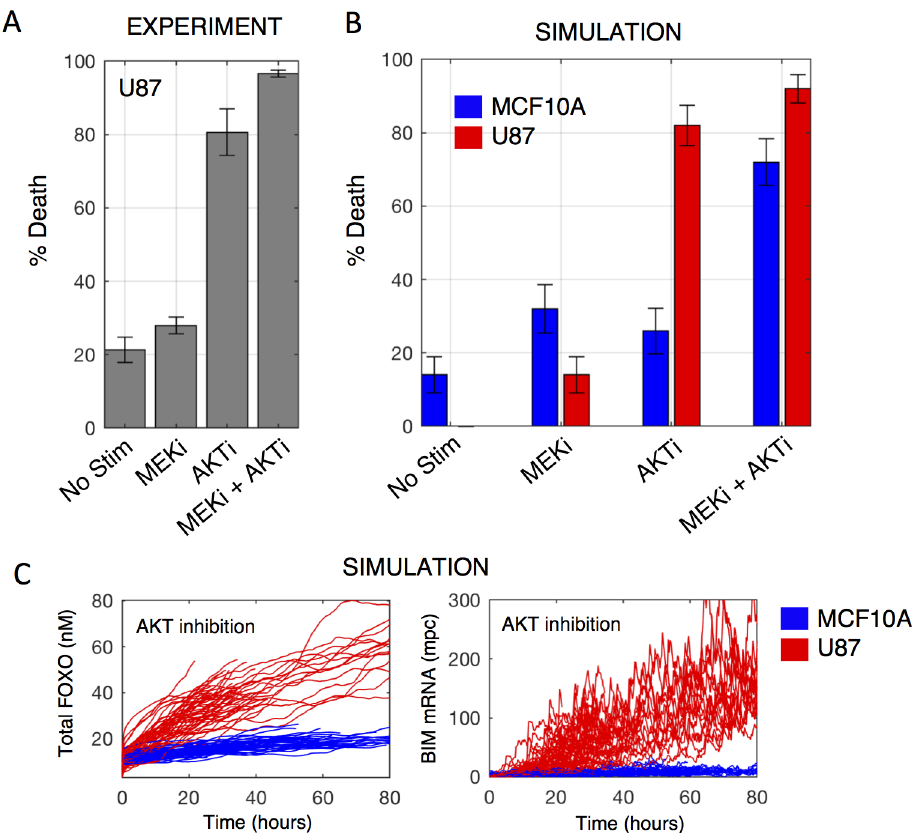
Fig 8. Predicting cell death responses in U87 cells. A) Serum-starved U87 cells were treated as indicated (MEKi- 10 μ M; AKTi-10 μ M) for 48 hours and percent of cell death was measured via flow cytometry. B) Simulation results comparing cell death responses of a U87-tailored (red) and MCF10A-tailored (blue) model. C) Single cell traces comparing U87 (red) to MCF10A (blue) total FOXO (nuclear + cytoplasmic forms; left) and BIM mRNA levels